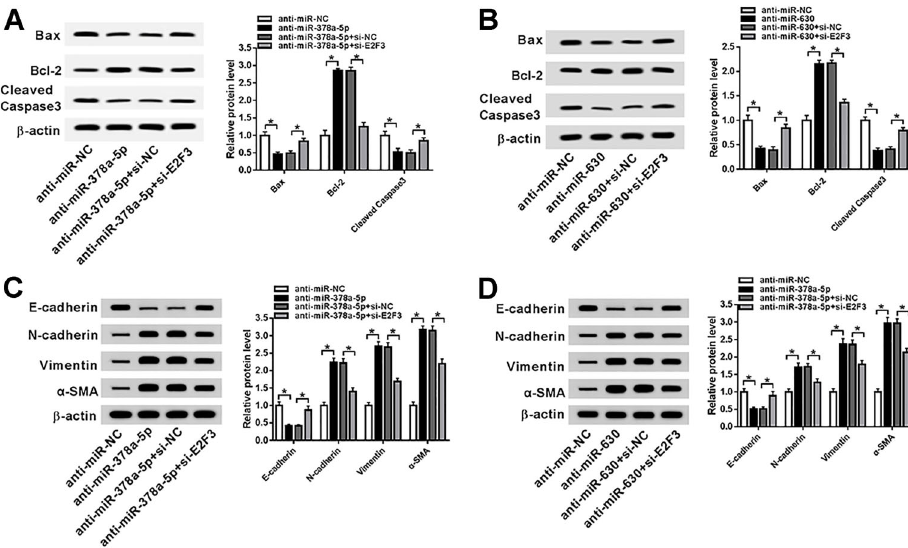
Figure 7. Western blot was used to examine the protein expression levels in transfected SRA01/04 cells of Bax, Bcl-2, and cleaved caspase 3 ( A and B ), as well as with E-cadherin, N-cadherin, vimentin, and a -SMA ( C and D ). Data are reported as means ± SD. *P o 0.05 ( t -test or